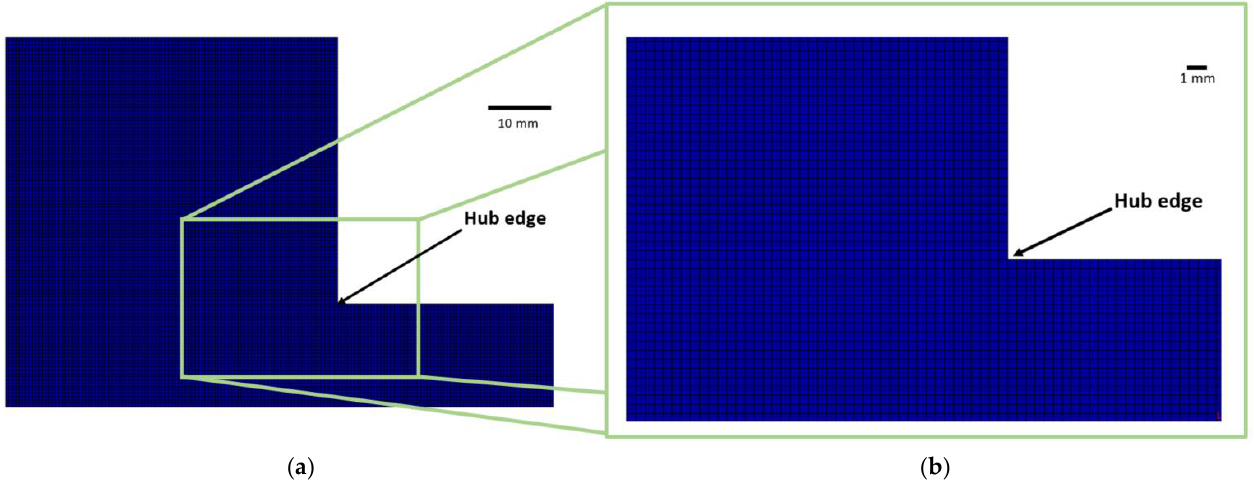
Figure 3. Mesh used in FEM simulations: ( a ) general view, ( b ) detail view at the hub edge where stress concentration appears.